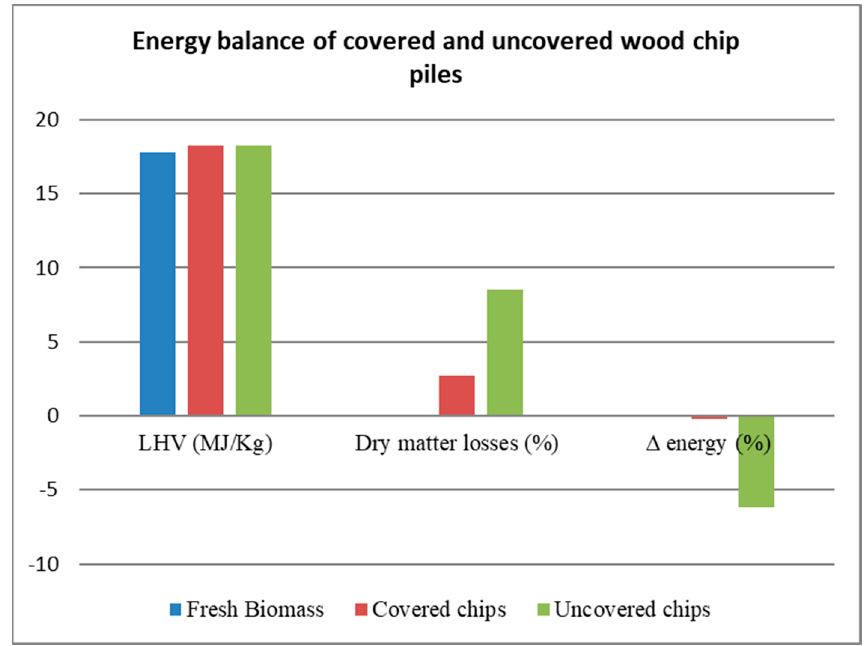
Figure 7. Variations in energy content according to storage systems.